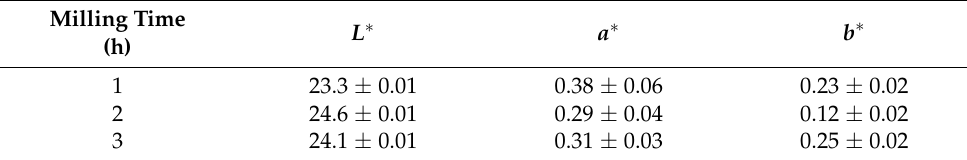
Table 7. Colorimetric results of the CB dispersion prepared with SMA-3000. Milling